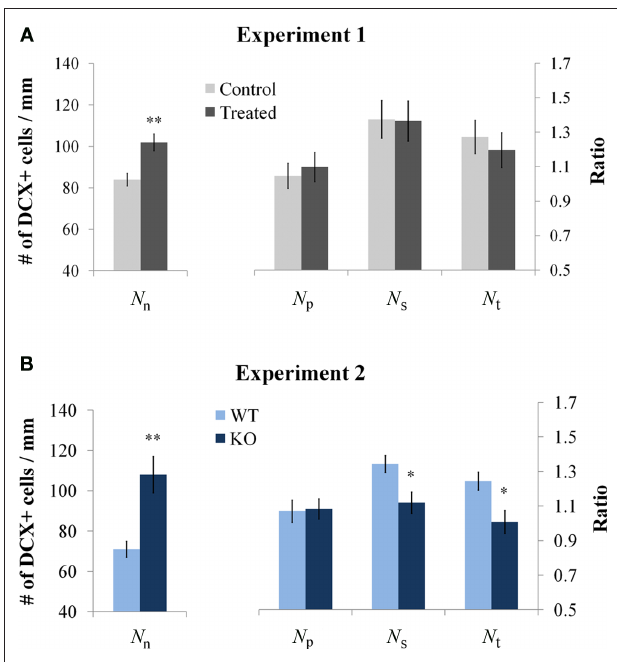
Figure 3 | Comparison between animal groups. (A) In experiment 1 the number of DCX-positive neurons was increased in the treated rat group with no change in dendritic complexity. (B) In experiment 2 the number of DCX-positive neurons was increased in the KO mice but secondary and tertiary branching were reduced.